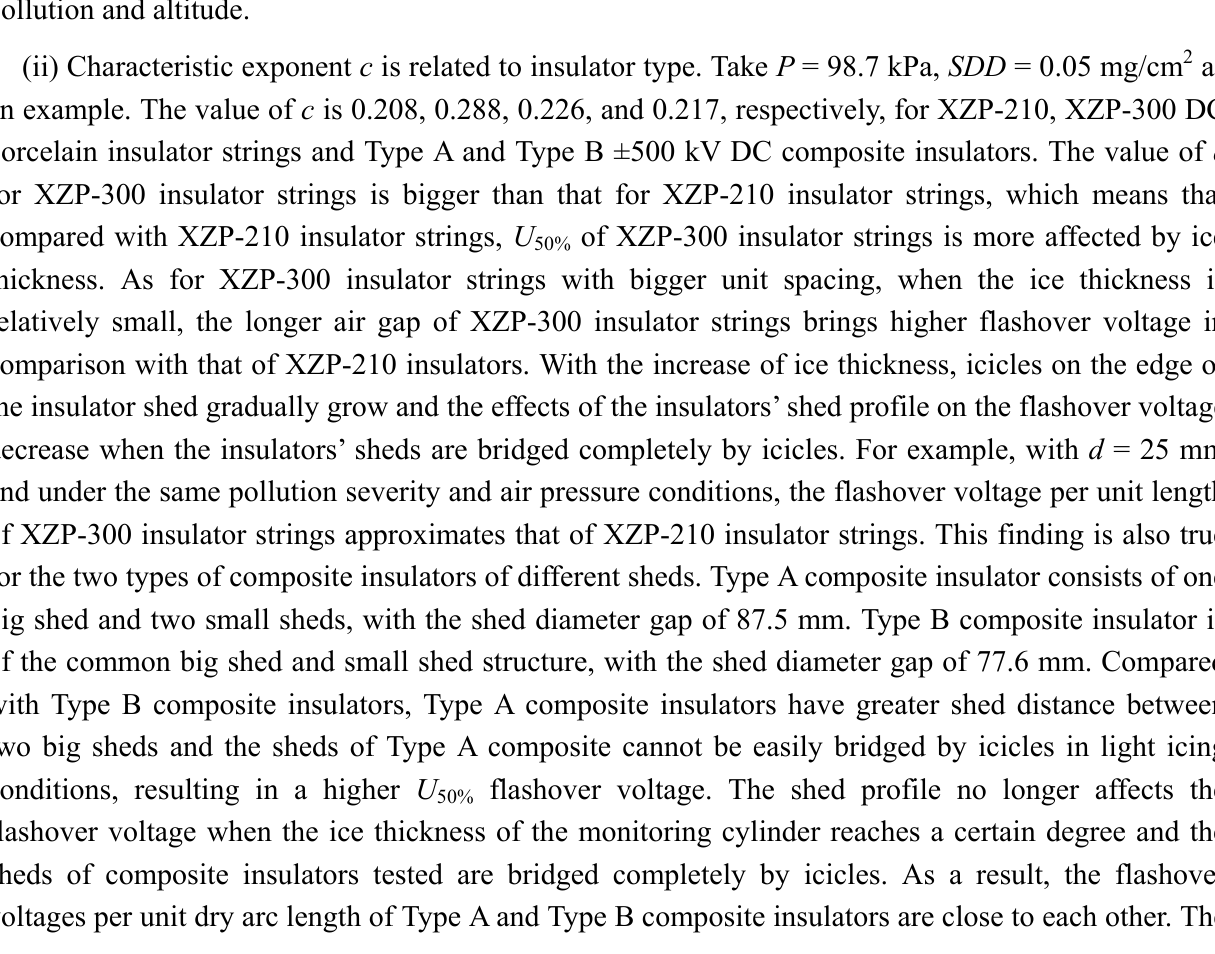
, c , and R 2 according to the test results in Figures 5 to Figure 7 d